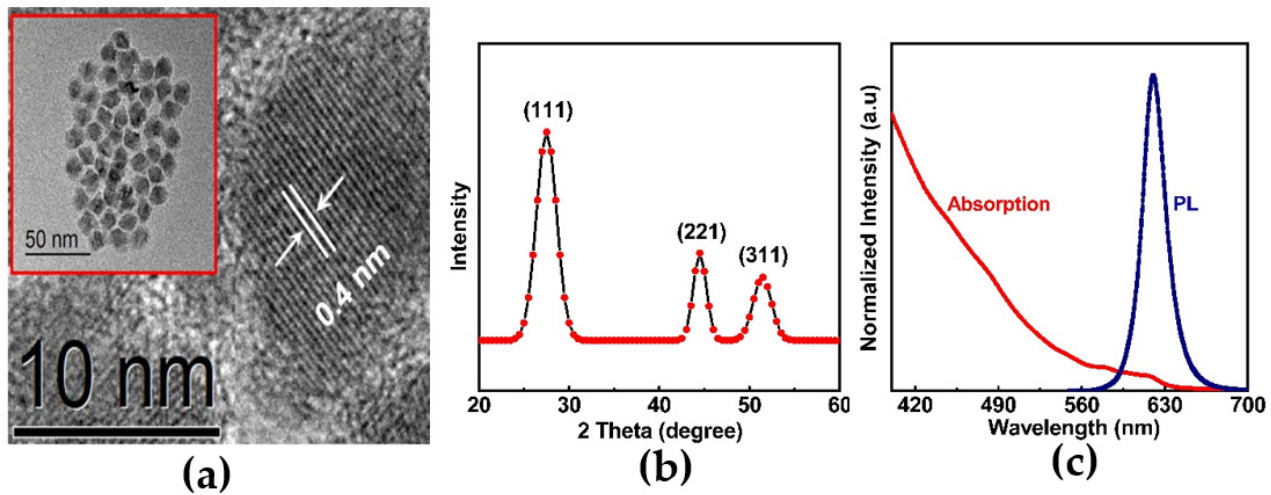
Figure 1. Characteristics of CdSe/ZnS core–shell QDs; ( a ) HRTEM and TEM images; ( b ) XRD pattern; and ( c ) UV − vis absorption and PL spectra.